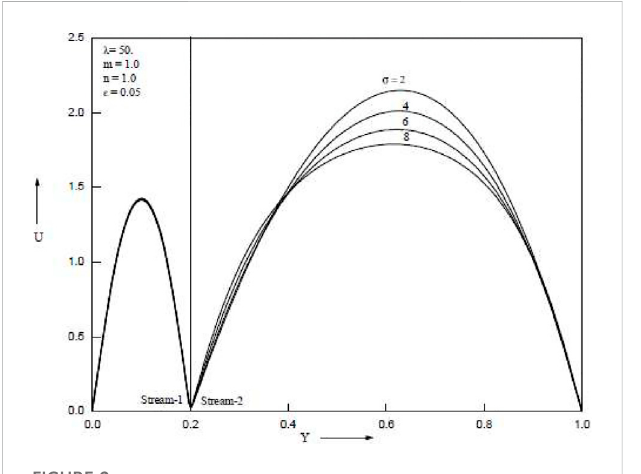
FIGURE 4 Temperature for various values of σ = 2, 4, 6, 8.